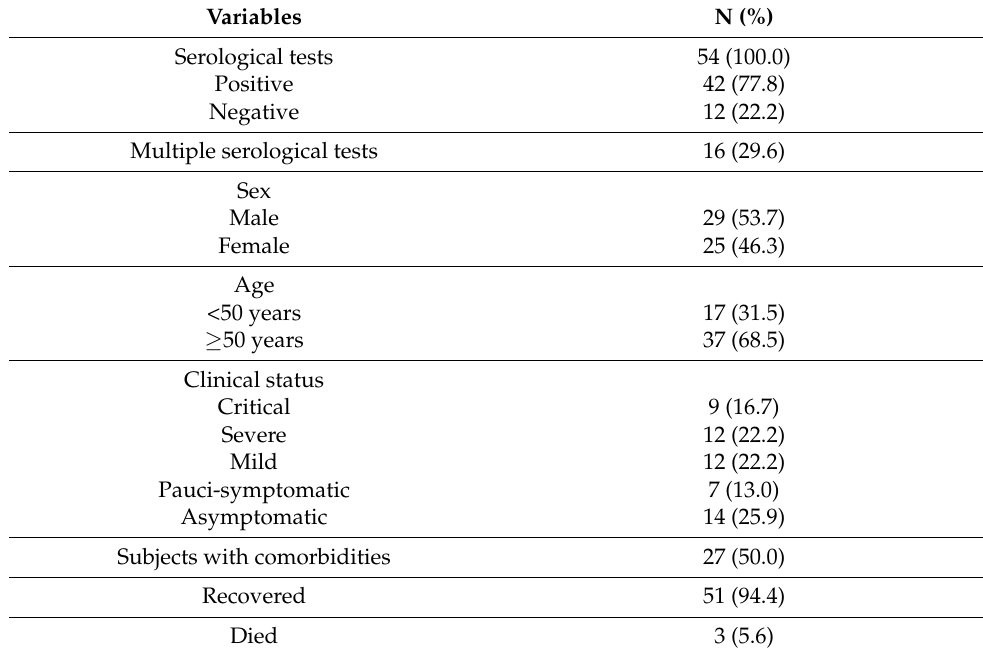
Table 1. Descriptive characteristics of COVID-19